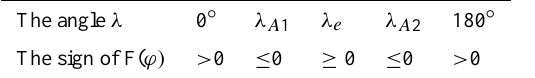
Table 1. Characteristic values of propagation angles of MHD waves ahead of a fast shock wave and the corresponding signs of function F( ϕ) . The angle λ 0 ◦ λ A 1 λ e λ A 2 180 ◦ The sign of F( ϕ) > 0 ≤ 0 ≥ 0 ≤ 0 > 0